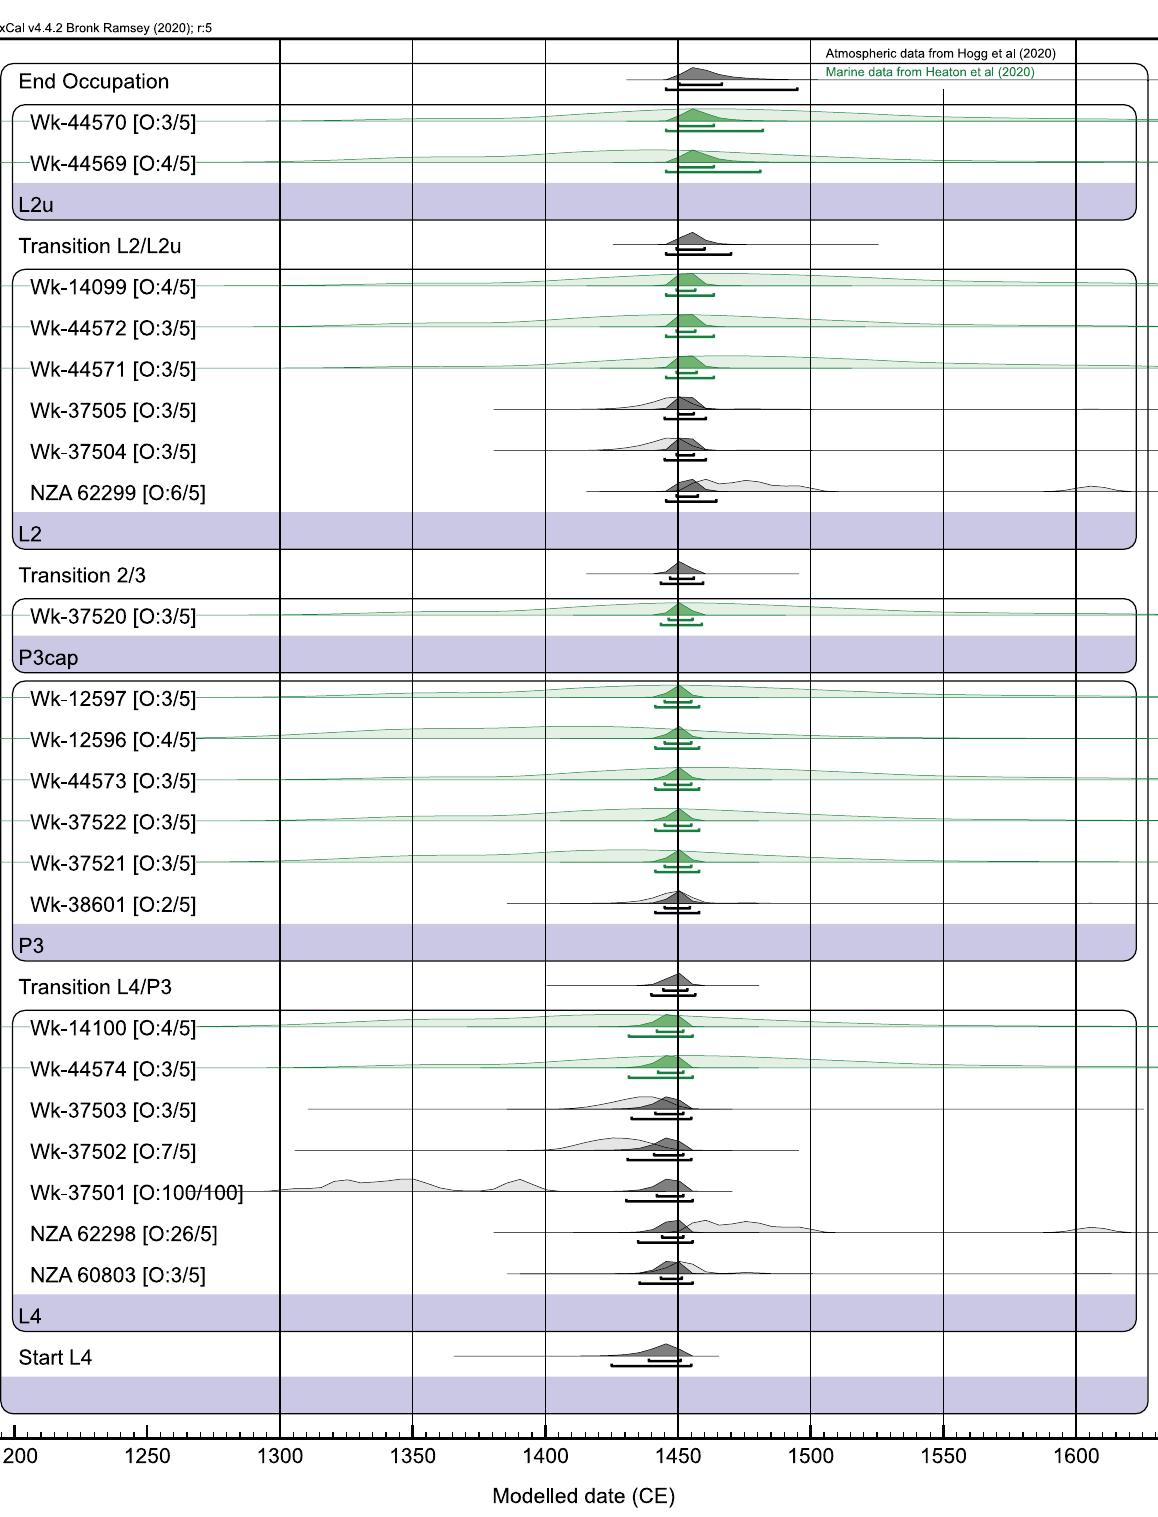
PLOS ONE | https://doi.org/10.1371/journal.pone.0247643 April 14,